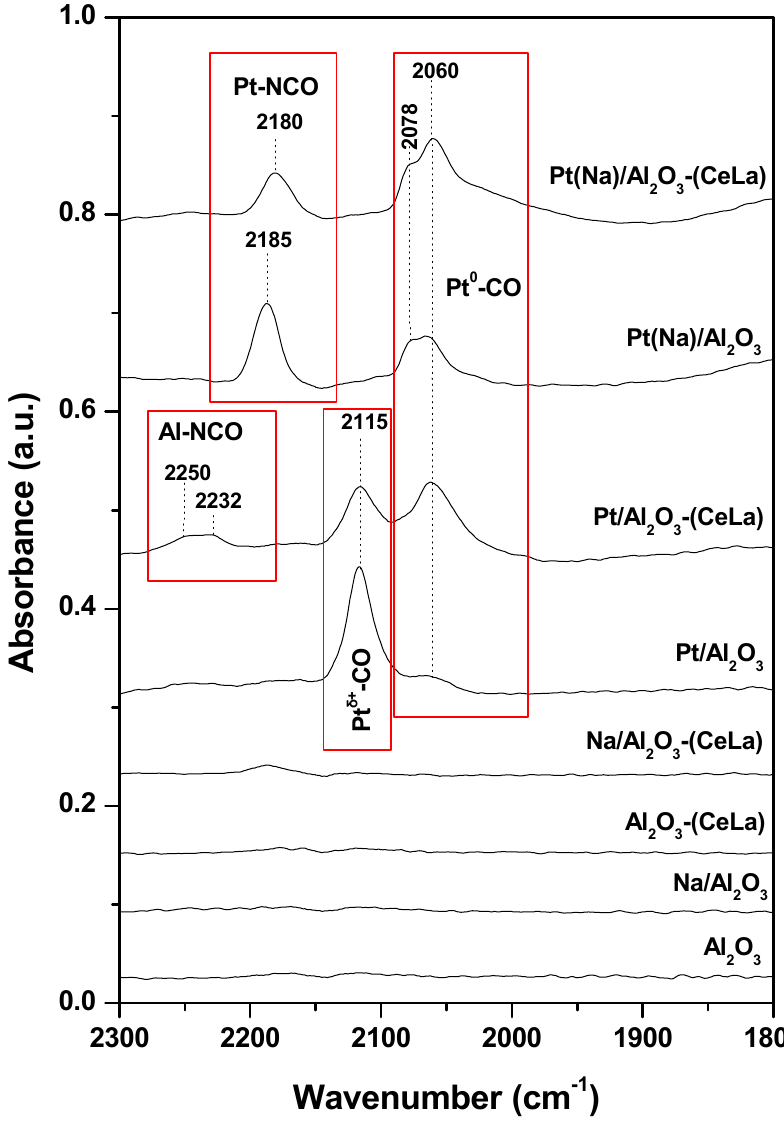
Figure 23. In-situ DRIFT spectra during simulated TWC reaction conditions (1000 ppm NO + 1067 ppm C 3 H 6 + 7000 ppm CO + 7800 ppm O 2 ; F t = 80 cm 3 /min; T = 200 ◦ C). (Reproduced with permission from Ref. [96]. Copyright 2008, Elsevier).